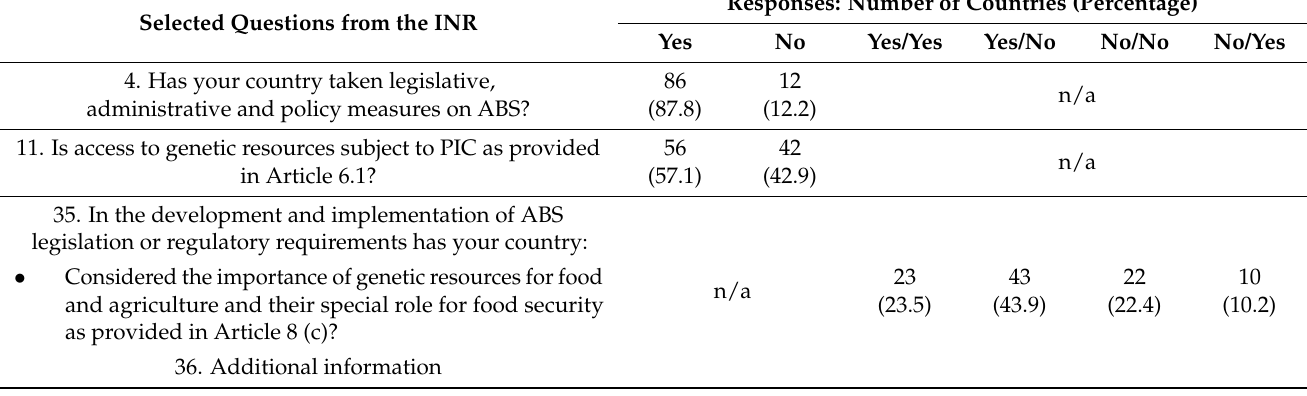
Table 2. Summary of replies to questions related to access measures and GRFA, included in the INR; number of countries and percentage of